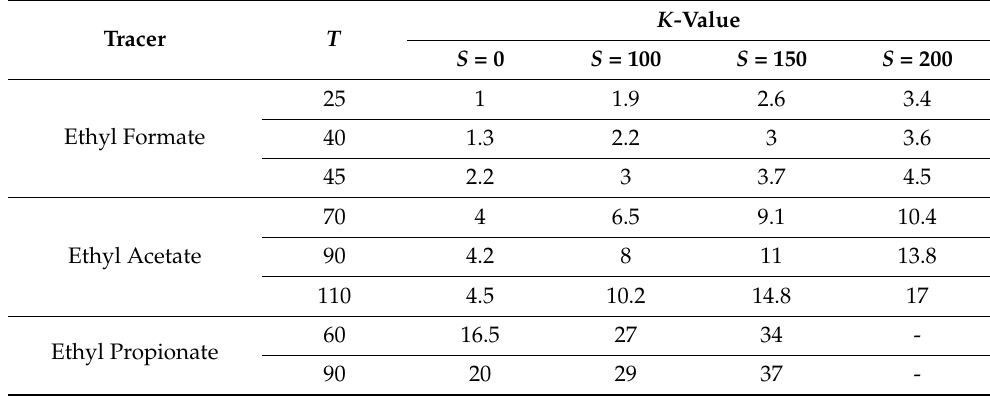
Table 3. Partition coefficients ( K -value) of ethyl formate, ethyl acetate, and ethyl propionate in a two-phase oil–water system (1:1) at various temperatures ( T , ◦ C) and water salinity ( S , g/L). Tracer